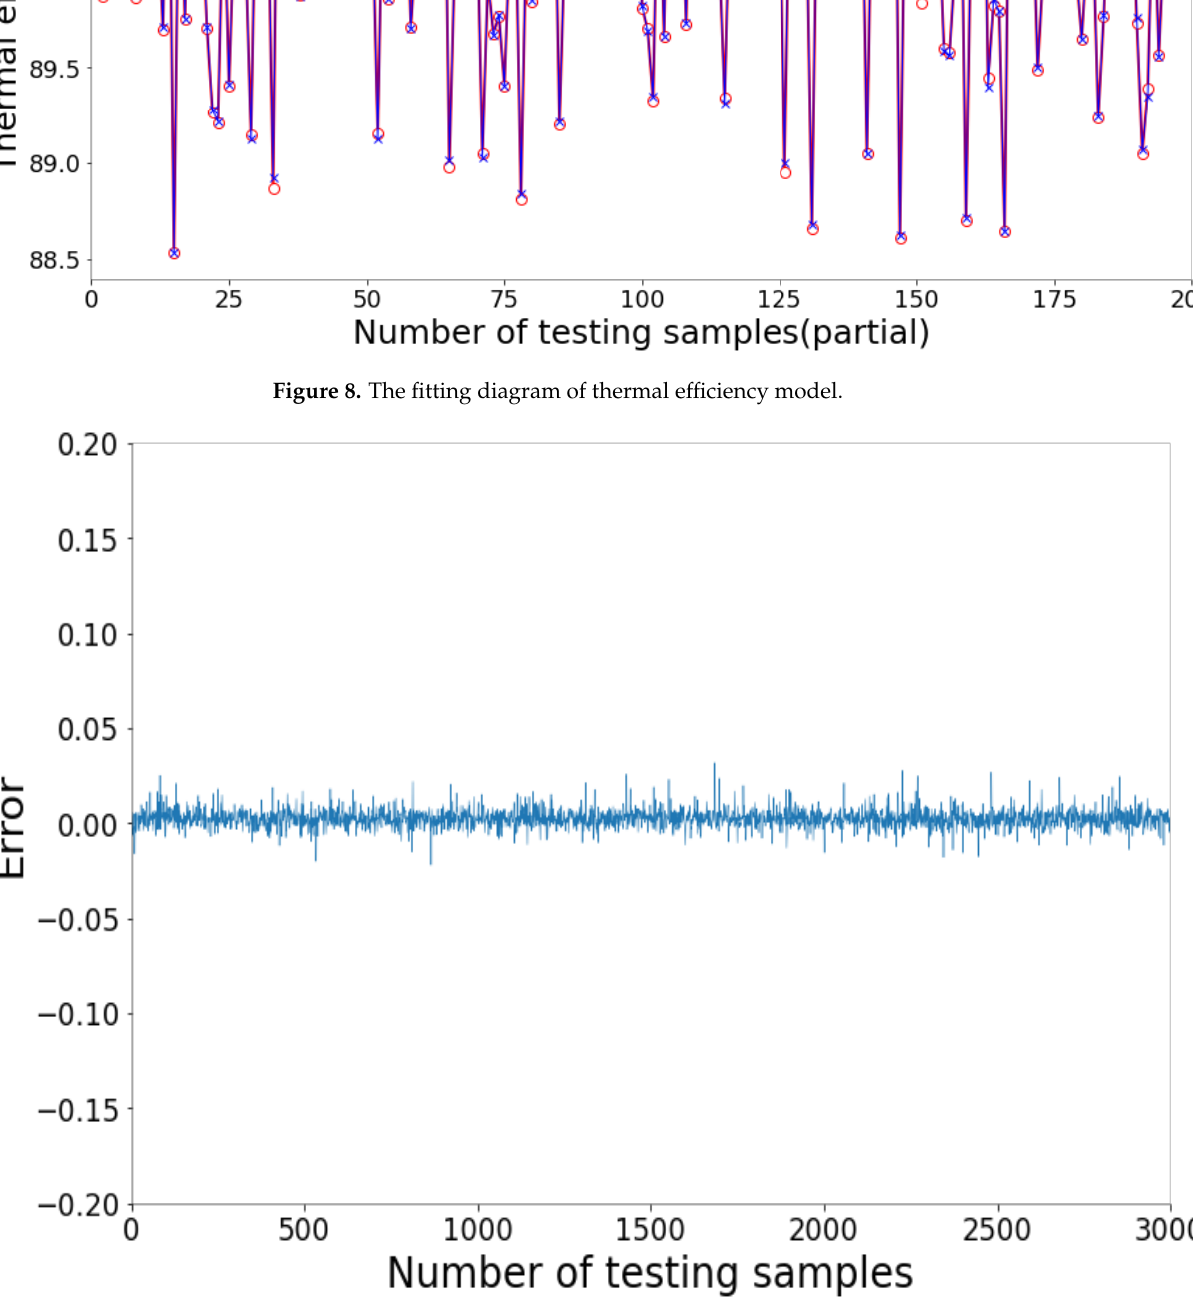
Figure 9. The error diagram of thermal efficiency model.